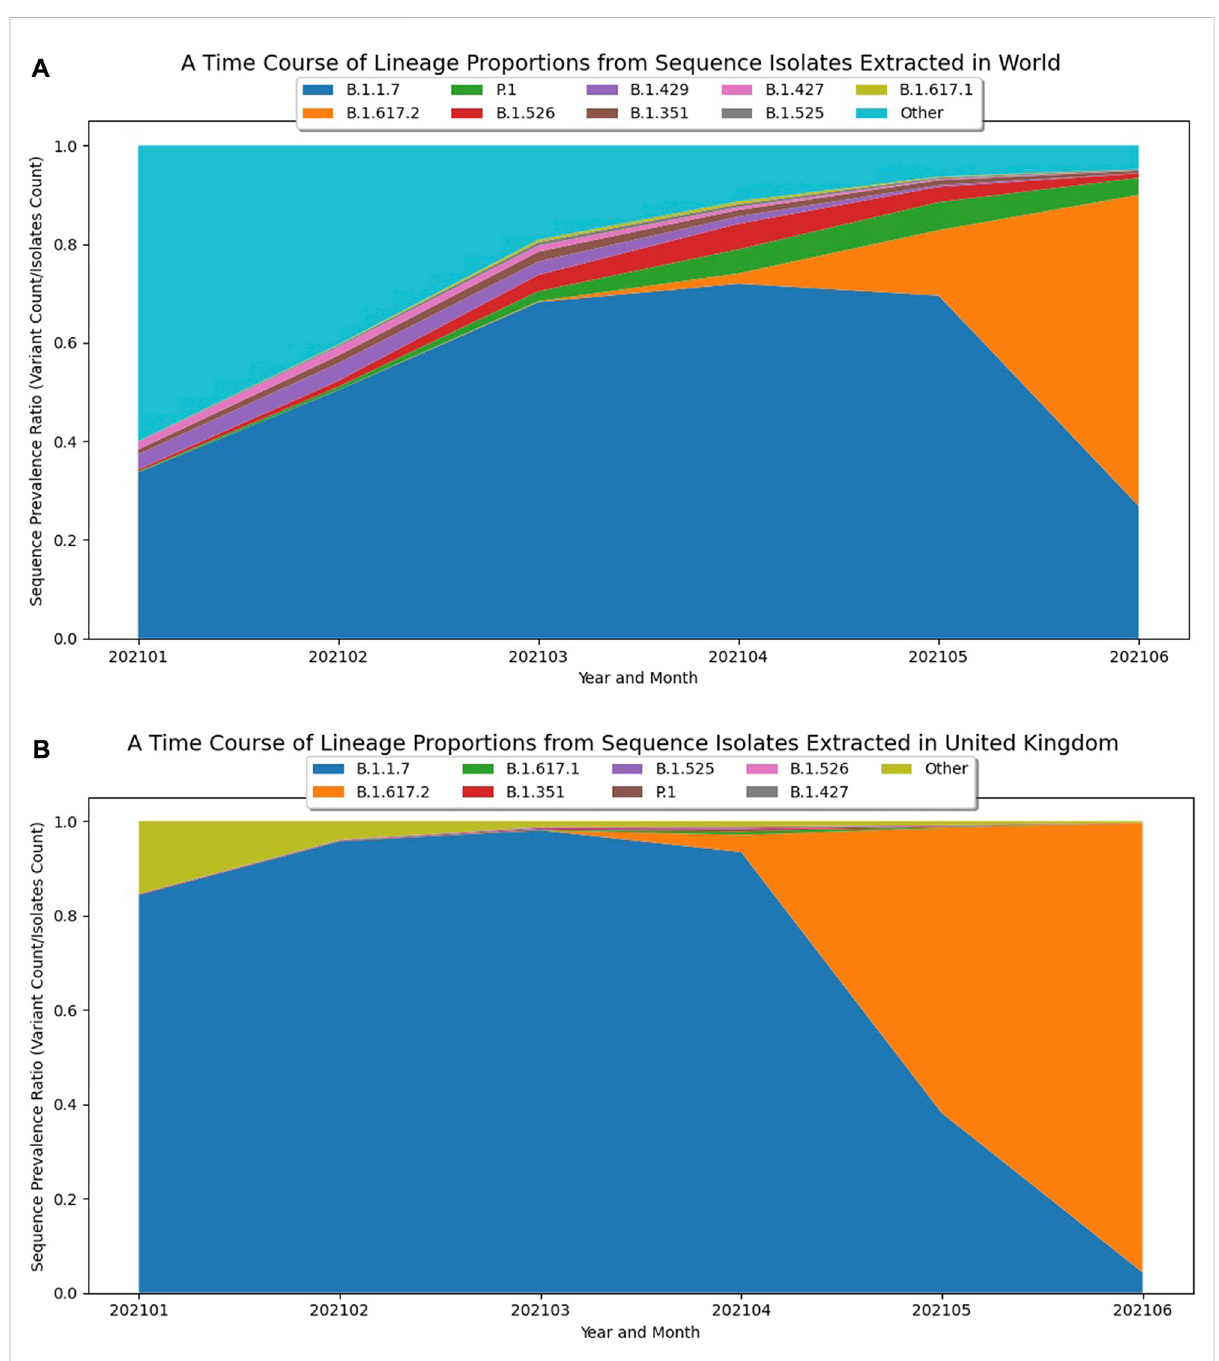
FIGURE 2 VisualizingtheEmergenceoftheB.1.617.2(Delta)Variant. (A) AplotofglobaltrendsovertimebasedonGISAIDdatauptoJune2021tovisualize theearlygrowth dynamics ofB.1.617.2(Delta).The graphdisplays the10PANGOlineageswiththemostsubstantialglobalprevalencedynamicsover a six-month time frame, with the early emergence of B.1.671.2 and the sudden sharp decline of B.1.1.7 (Alpha) clearly evident. (B) A plot of growth trendsforDeltaintheUnitedKingdombasedonGISAIDdatauptoJune2021.ThegraphdisplaysthePANGOlineageswiththemostsubstantial global prevalence dynamics over a six-month time frame solely within the United Kingdom and shows the local growth of B.1.617.2 and decline of